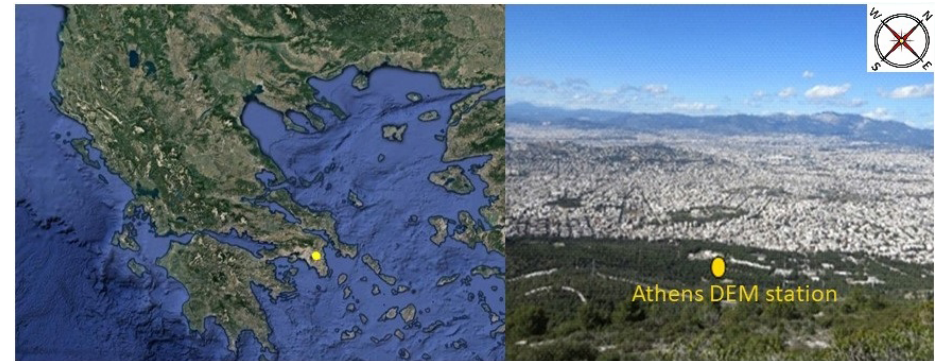
Figure 1. The Demokritos Atmospheric Aerosol Measurement station in Ag. Paraskevi, Athens, Greece, DEM (GAW, ACTRIS). The maps were obtained from © Google Maps (http://maps.google.com, last access: 25 January 2022) imagery 2021 Terrametrics, Mapdata 2021 and modified by the